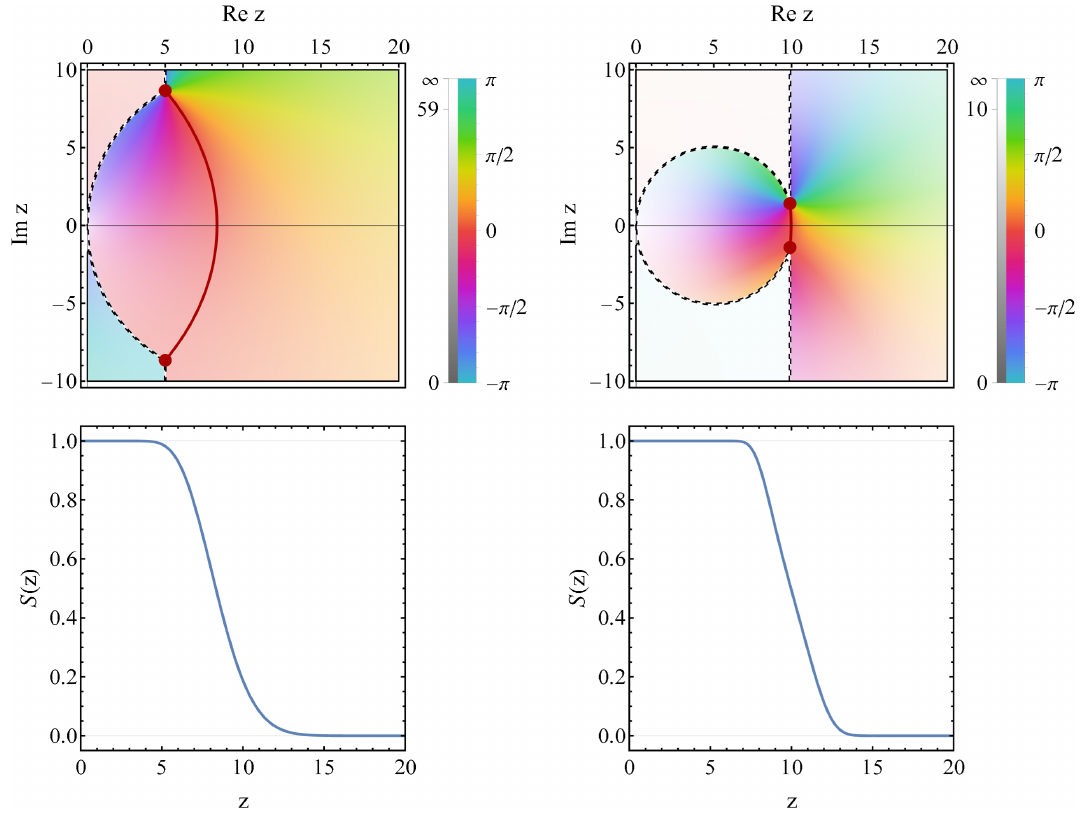
Figure 6 . The super-adiabatic singulant F ( z ) in dS for ˜ κ = 5 (upper left panel) and ˜ κ = 9 . 9 (upper right panel), with the dS-corrected mass µ = 10 . The hue represents the phase arg F ( z ) while the brightness represents the modulus | F ( z ) | . In both panels, the dark red line is the Stokes line joining the complex turning points. The lower two panels show the Stokes multiplier S ( z ) corresponding to the parameters chosen